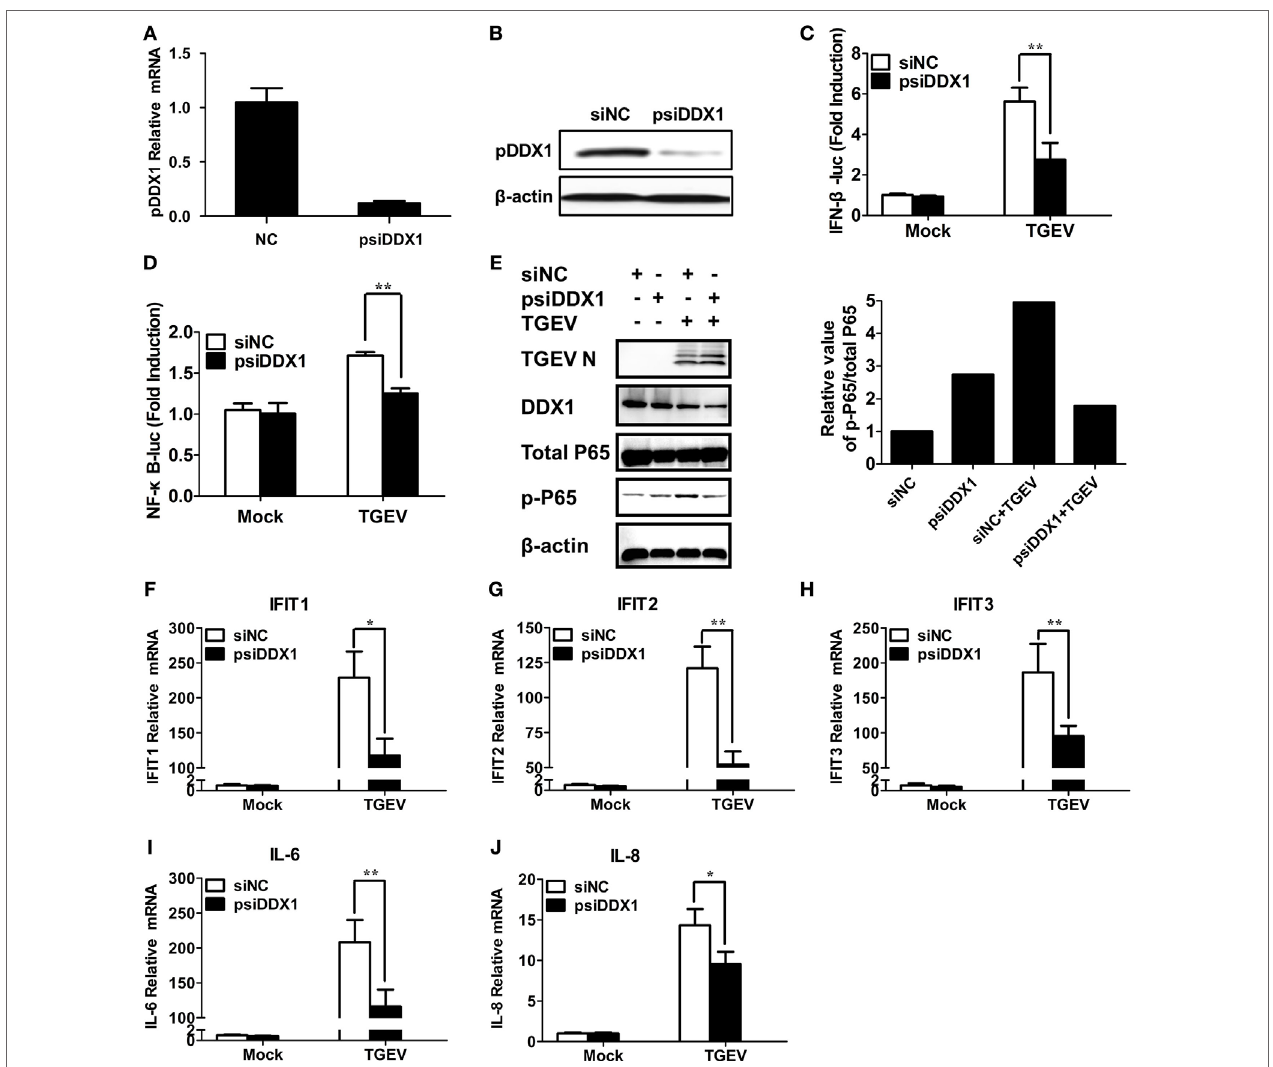
FigUre 6 | Involvement of DDX1 in the antiviral response triggered by transmissible gastroenteritis virus (TGEV). (a,B) Assessment of the silencing efficiency of psiDDX1. PK-15 cells were transfected with 50 nM/well of psiDDX1 or siNC for 36 h each. The expression levels of porcine DDX1 were determined by RT-qPCR (a) and western blot assay (B) . (c,D) PK-15 cells were cotransfected with psiDDX1 or siNC, along with pRL-TK, IFN- β -Luc (c) , or NF- κ B-Luc (D) . At 12 h post- transfection, cells were mock infected or infected with TGEV [multiplicity of infection (MOI) = 0.5]. Dual luciferase assays were performed at 24 hpi. (e) PK-15 cells were transfected with psiDDX1 or siNC, and 12 h later, cells were mock infected or infected with TGEV (MOI = 0.5) for 24 h. Then, the cells were collected for western blot assay with specific antibodies against p65, p-p65, DDX1, or TGEV N protein, using β -actin expression as a loading control. The ratio of phosphorylated/total p65 was analyzed using ImageJ Software. (F–J) PK-15 cells were treated as described for (e) and collected at 24 hpi. Cell RNAs were extracted for RT-qPCR to examine the mRNA expression levels of IFIT1 (F) , IFIT2 (g) , IFIT3 (h) , IL-6 (i) , and IL-8 (J) . The mRNA expression levels were normalized to porcine GAPDH transcripts. Values are the mean ± SD of three independent tests. * P < 0.05 or ** P < 0.01 compared with the siNC